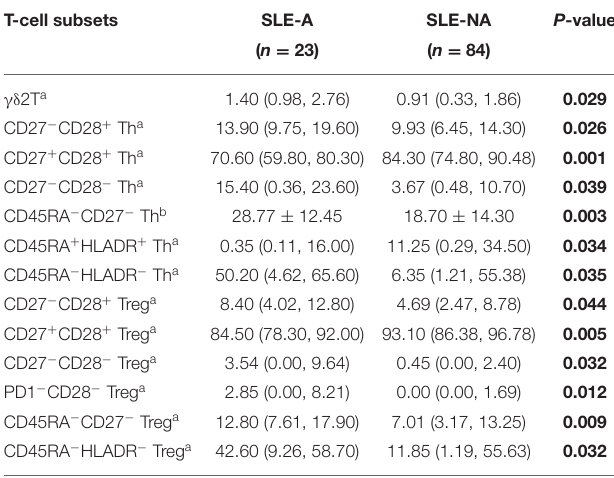
TABLE 3 | The abundance of 13 subsets of immune cells in SLE-A and SLE-NA